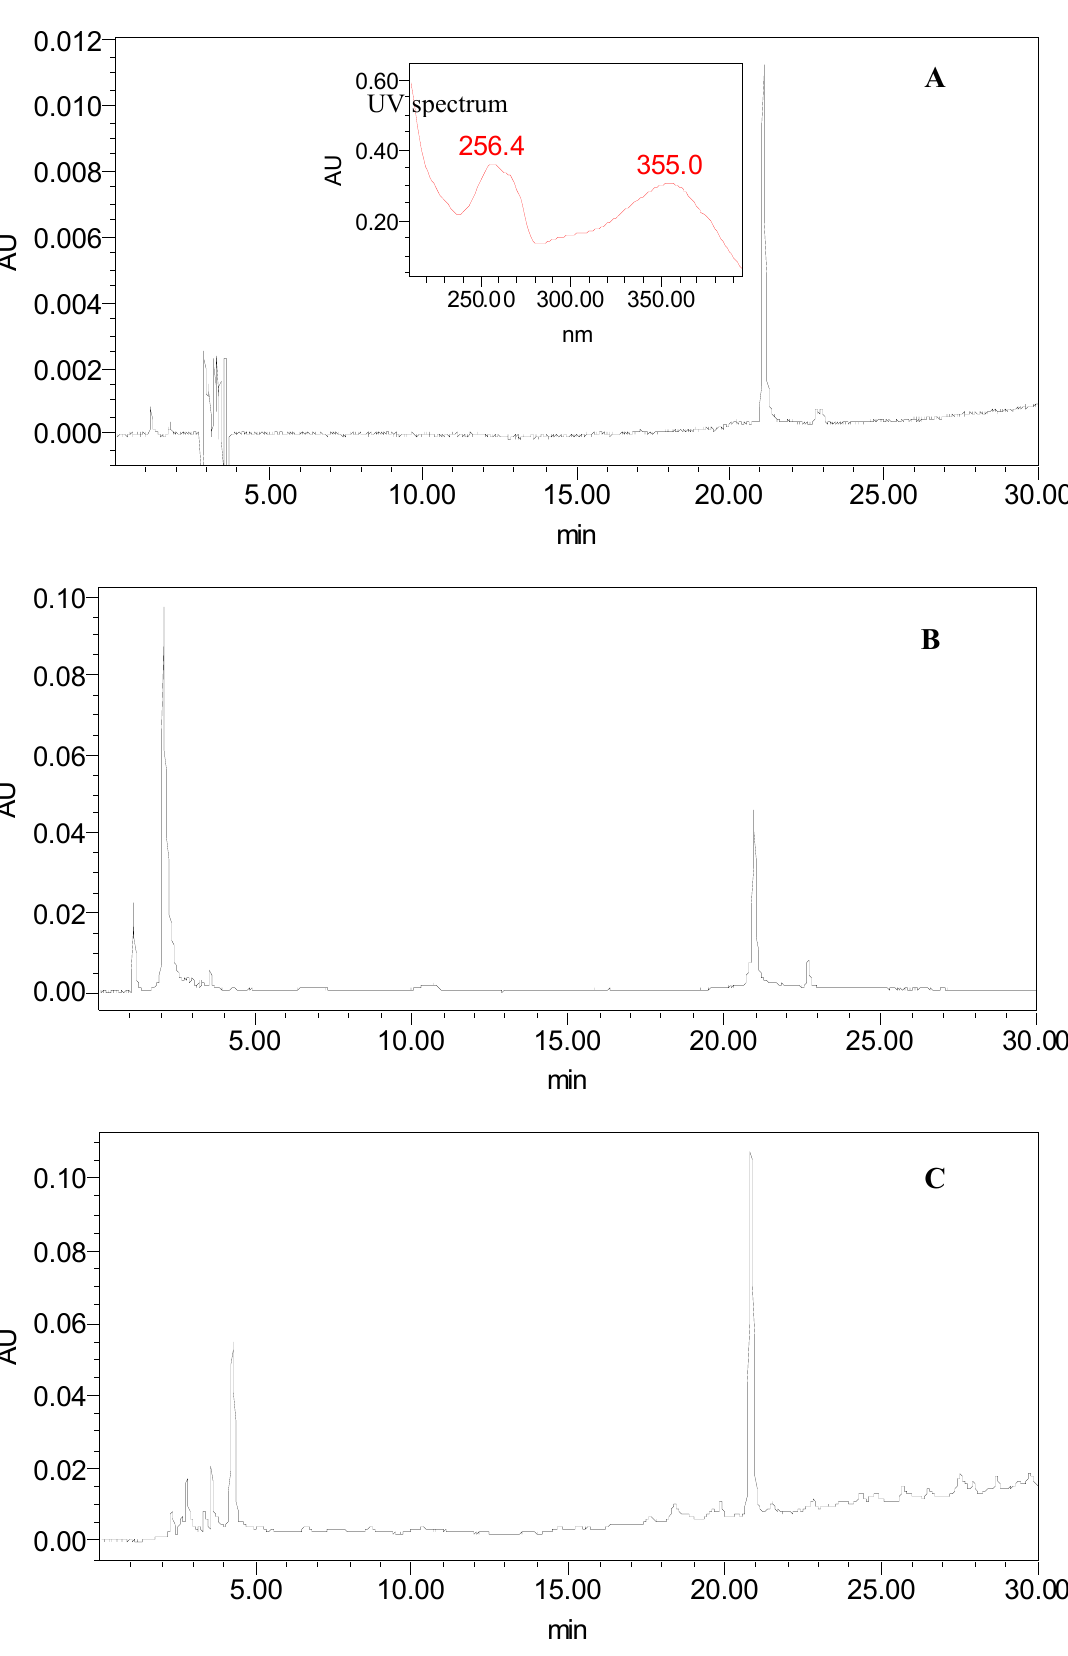
Figure 2. The HPLC chromatograms of the standard solution and brand 2 samples. ( A ) standard solution of rutin; ( B ) tobacco; ( C ) filter; ( D ) mainstream smoke; ( E ) burned